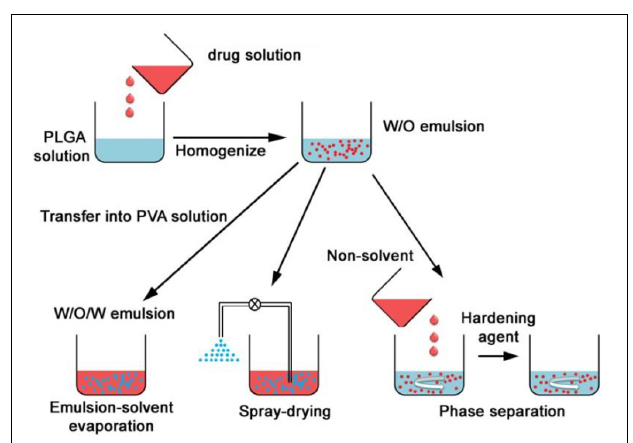
FIGURE 4 | Formation of PLGA nanoparticles by double (W/O/W) emulsion, spray drying and phase separation (coacervation) methods, adapted from Ding and Zhu